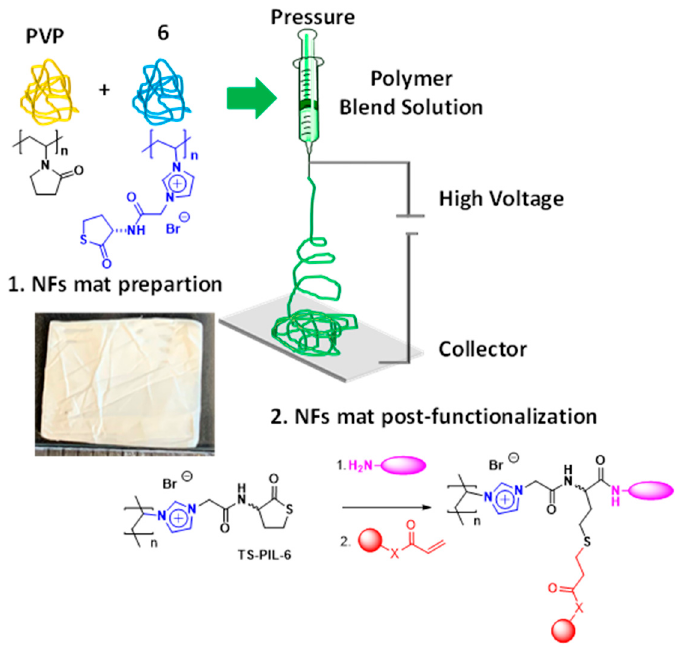
Figure 1. Preparation and post-functionalization of NFs mats derived from TS-PIL 6 .